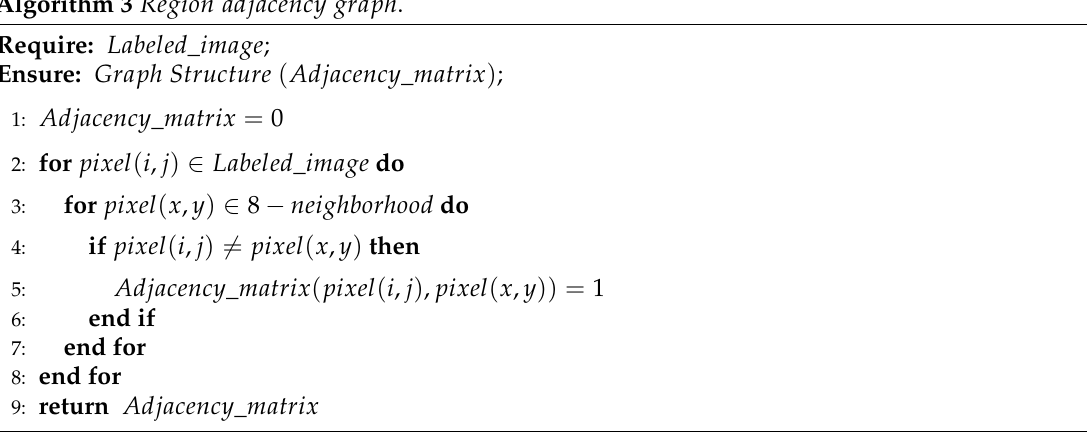
Algorithm 3 Region adjacency graph